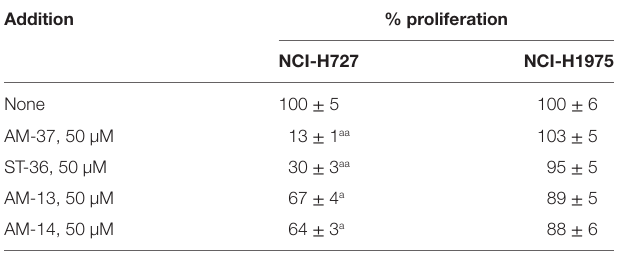
TaBle 3 | MTT proliferation assay using human lung cancer cell lines.